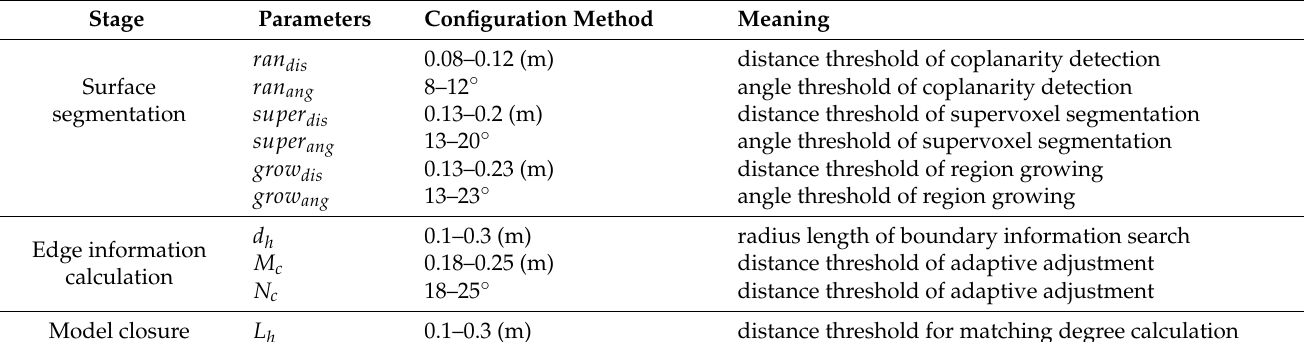
Table 2. Information of parameters.